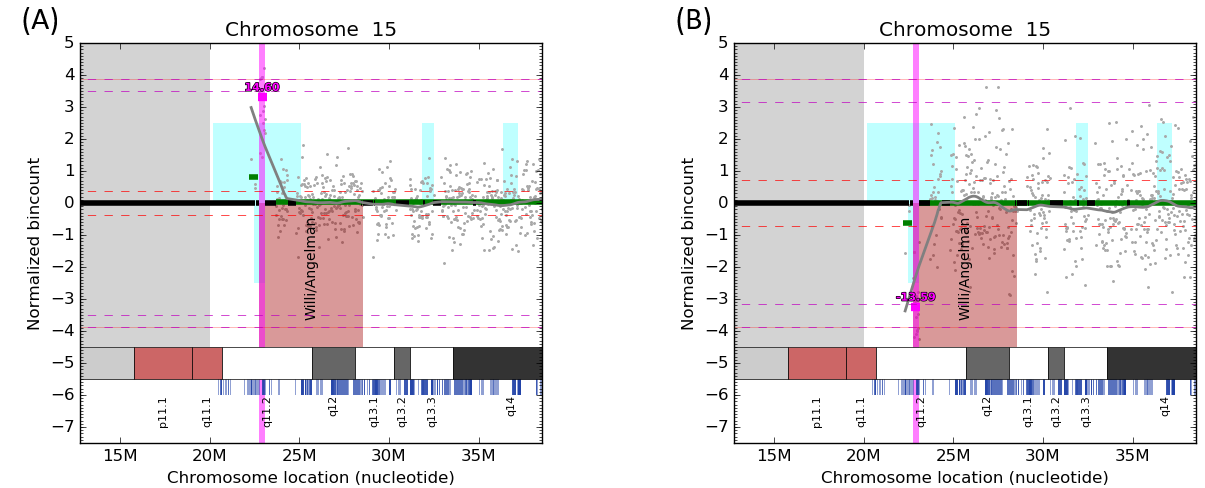
Figure 1. Visualization of CNV in the proximal region of 15q. Normalized read counts per bin are depicted as gray dots. The dup 15q11.2 ( A ) /del 15q11.2 ( B ) (approximately 320 kb long) is shown by the vertical line. The light gray vertical band depicts an unmappable centromere region. Black horizontal bands signify bins that did not pass quality metrics (centromere) and were thus excluded from the analysis. The approximated z-score for CNV is displayed over the magenta segment.